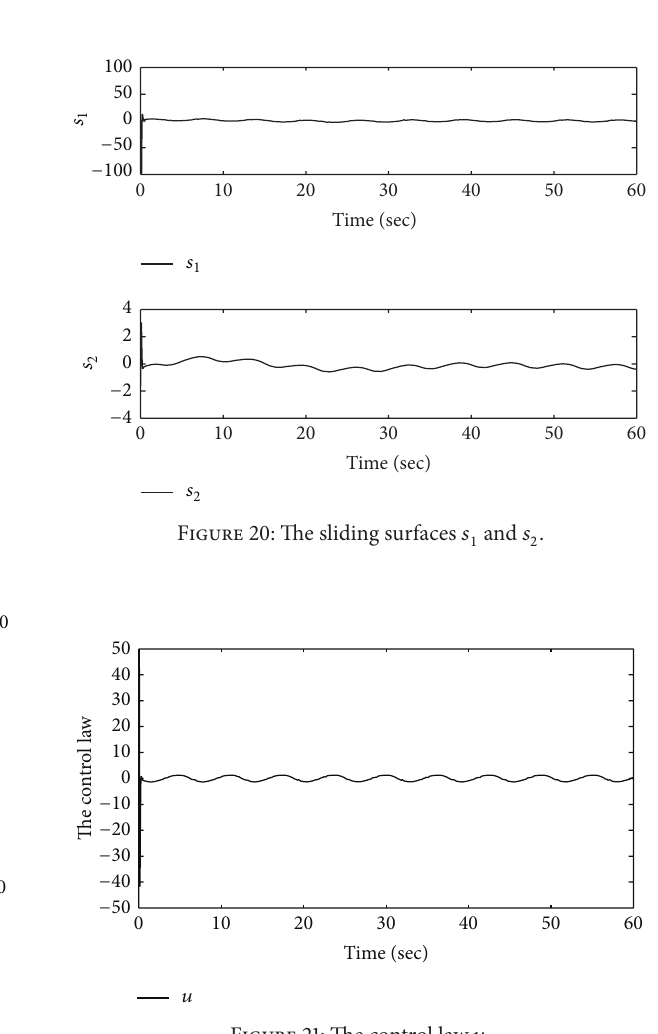
Figure 21: The control law 𝑢